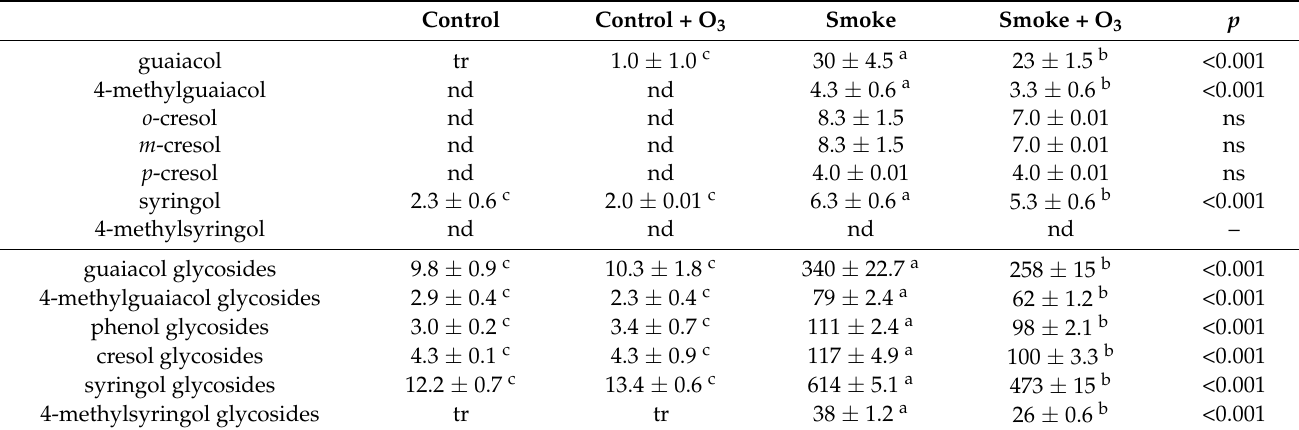
Data are means from three replicates ( n = 3) ± standard deviation; nd = not detected (<0.5 µ g/L); tr = trace (0.5–1 µ g/L). Different letters (within rows) indicate statistical significance ( p = 0.05, one-way ANOVA); ns = not significant. Volatile phenol glycosides measured as syringol glucose–glucoside equivalents.